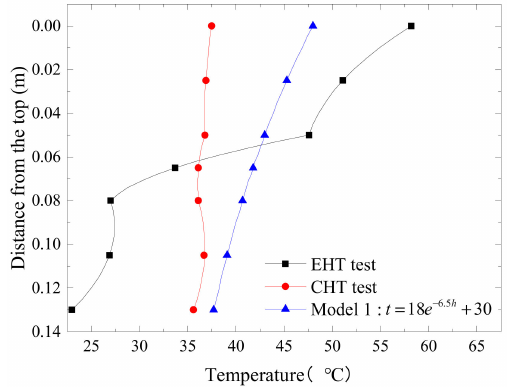
Figure 6. Comparison of the vertical temperature